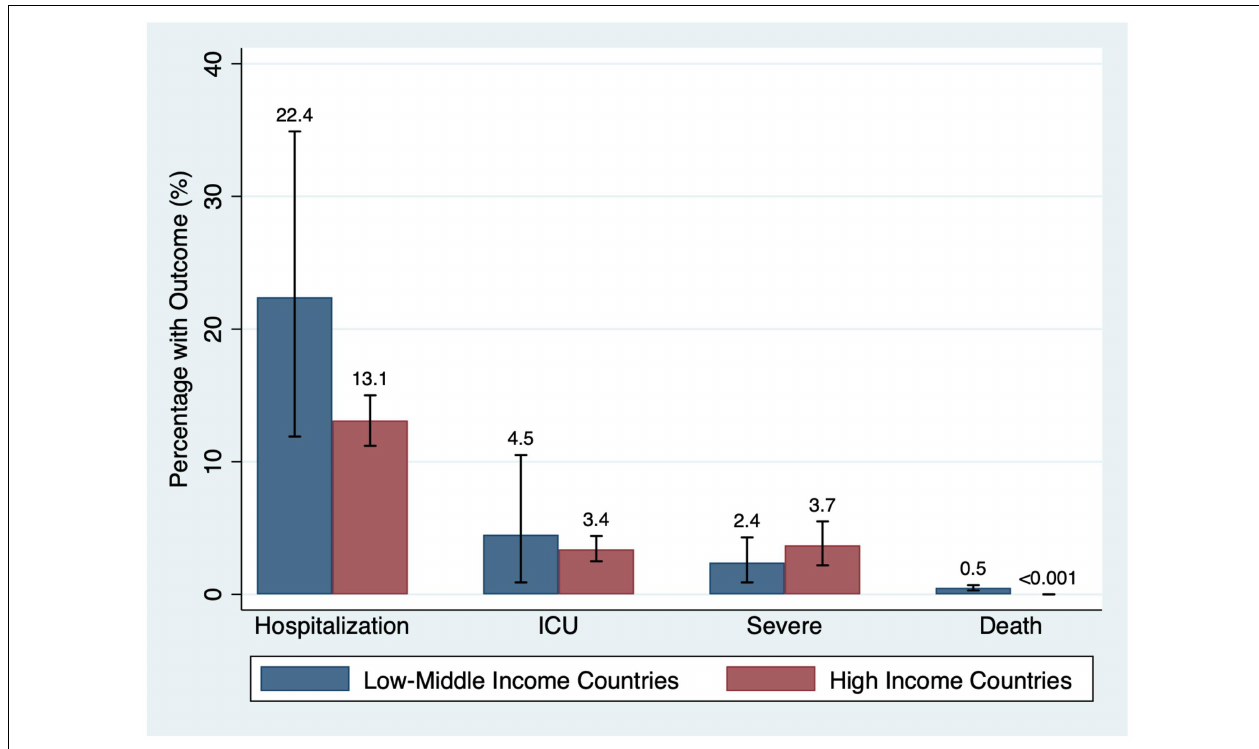
FIGURE 8 | Percentage of participants with outcomes by country income